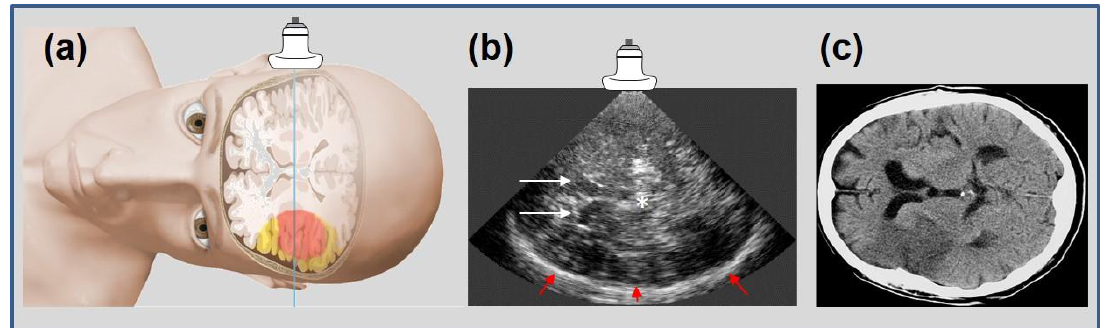
Figure 1. Schematic representation of insonation plane in transtemporal ultrasound imaging ( a ), adapted from [13] (with permission of copyright owner) with a corresponding “bilateral” B-mode image ( b ) with explanatory anatomical landmarks: white arrows = frontal horns of side ventricles; * = midline, third ventricle; red arrows = contralateral skull. Infarcted areas cannot be displayed in B-mode ultrasound. For orientation, comparison to conventional cerebral computed tomography scan, CCT, ( c ) with plane shifted by 90° accordingly, with an infarction in the hemisphere “contralateral” to the probe.